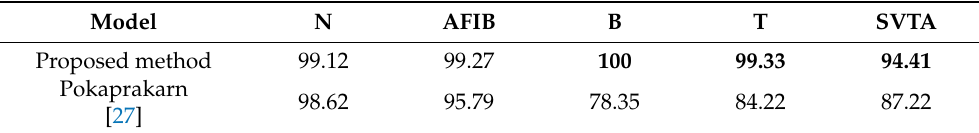
Table 7. Comparison of proposed and recent (Pokaprakarn et al., 2021) methods for small ECG rhythm samples.